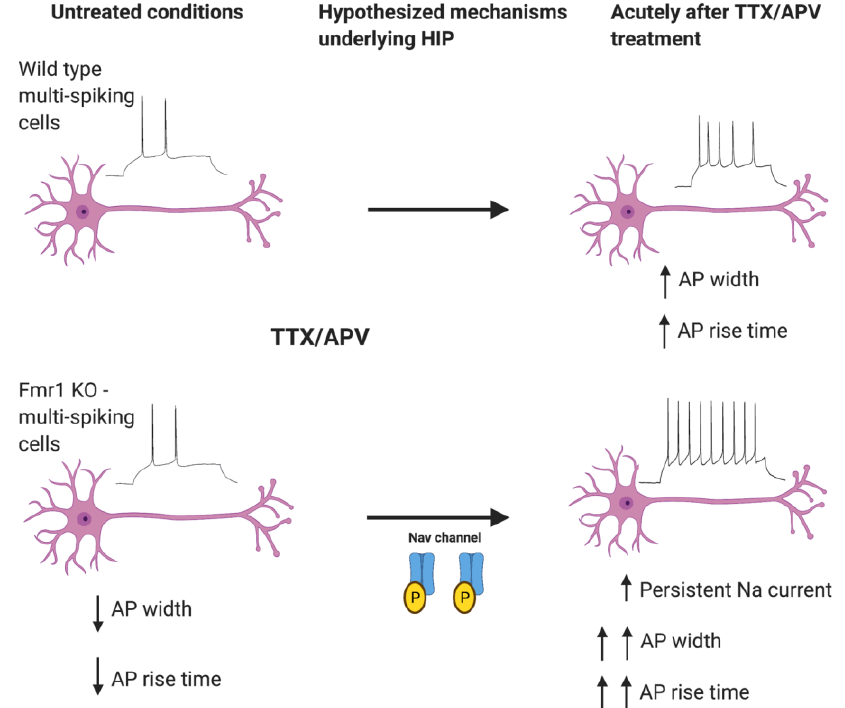
Figure 4. Activity deprivation triggered hyperexcitability in multi-spiking Fmr1 KO neurons. Activity deprivation led to exaggerated HIP in multi-spiking Fmr1 KO neurons, which resulted in a hyperexcitable phenotype compared with treated WT neurons. The excitability changes correlated with changes in the action potential waveform, which were changed to a greater extent in the Fmr1 KO. We hypothesize that increased phosphorylation of Nav channels contributes to exaggerated expression of HIP in Fmr1 KO neurons. FXS is best known as a disorder rooted in altered local protein synthesis [27], and dysregulated translation and protein stability has been reported in the dendrites, spines, and axons [33,114]. Yet, 48 h chemical drug treatments that elicit HIP and synaptic scaling do not lead to exaggerated upregulation of plasticity-induced proteins such as ion chan- nels or ligand-gated receptors in Fmr1 KO neurons [116]. However, FMRP targets diverse sets of mRNAs, several of which also regulate translation, protein degradation, and post- translational mechanisms [37]. For example, we know that FMRP regulates ubiquitination pathways that are likely important for expression of long-term depression [117]. Interest- ingly, a proteomics analysis from our lab identified greater changes in Gene Ontology modules associated with regulating phosphorylation [116]. Thus, we consider the possi- bility that loss of FMRP may lead to increased translation of phosphorylation and degra- dation machinery that ultimately drive complex changes in ion channel constellation and excitability during HIP. Although the above paragraphs mainly concern how HIP is